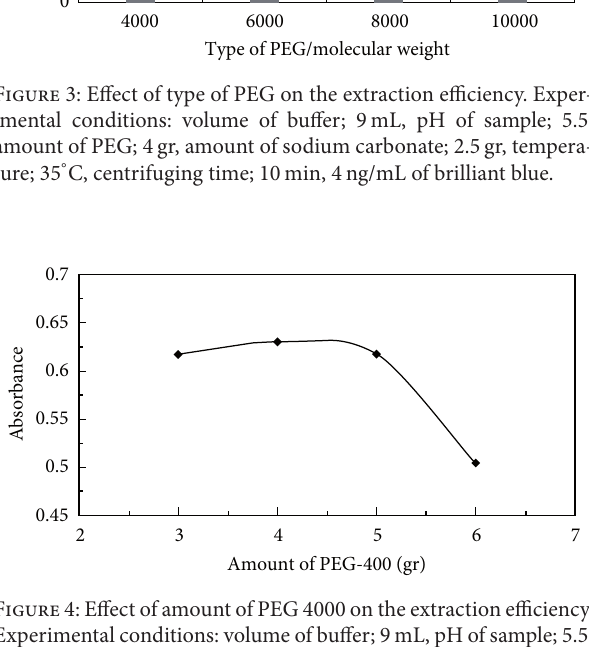
C, centrifuging time; ∘